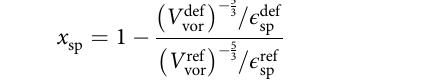
Considering the closeness of the crystal and electronic structures between group V and VI bcc elements, one would